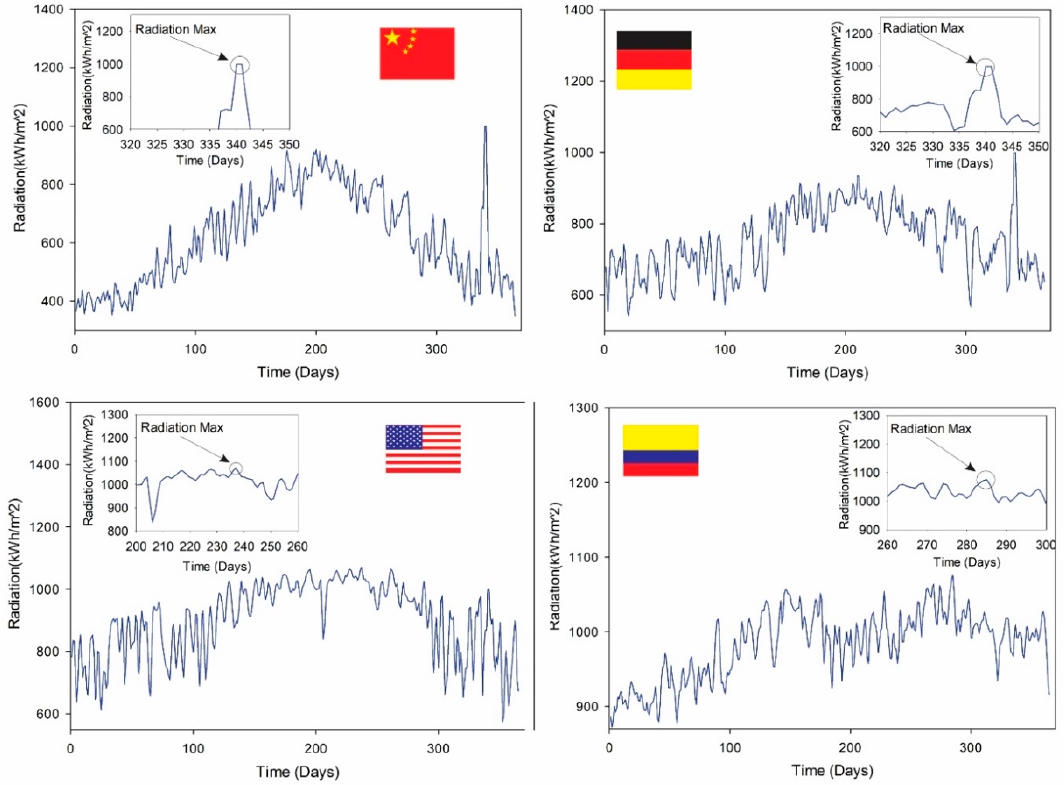
Figure 6. Solar radiation for each location.